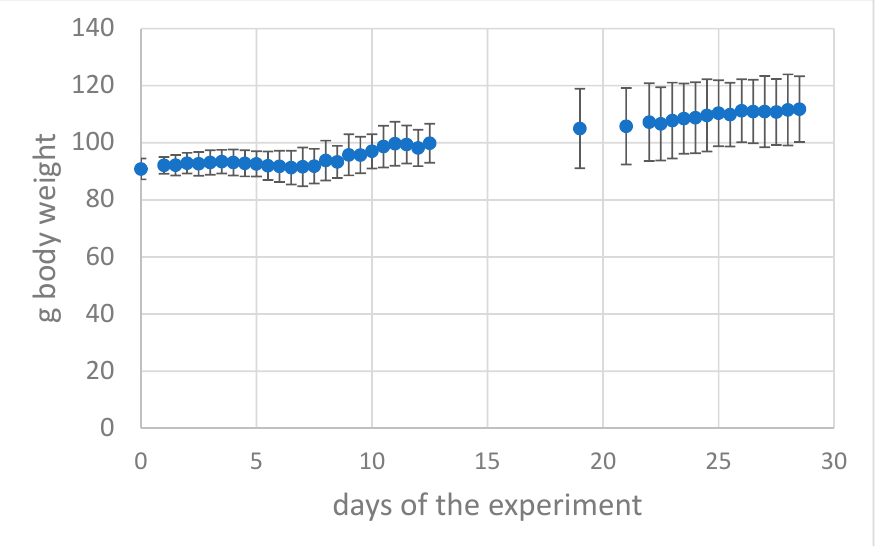
Figure 2. Body weight of the group G2 with a SARS-CoV-2 epi-ocular primary infection then 21 days later (challenge) with intranasal re-infection with SARS-CoV-2 virus (mean of n = 7 animals + -standard deviation). From day 4 to day 8 a slight weight loss, then recovery and increase of weight.